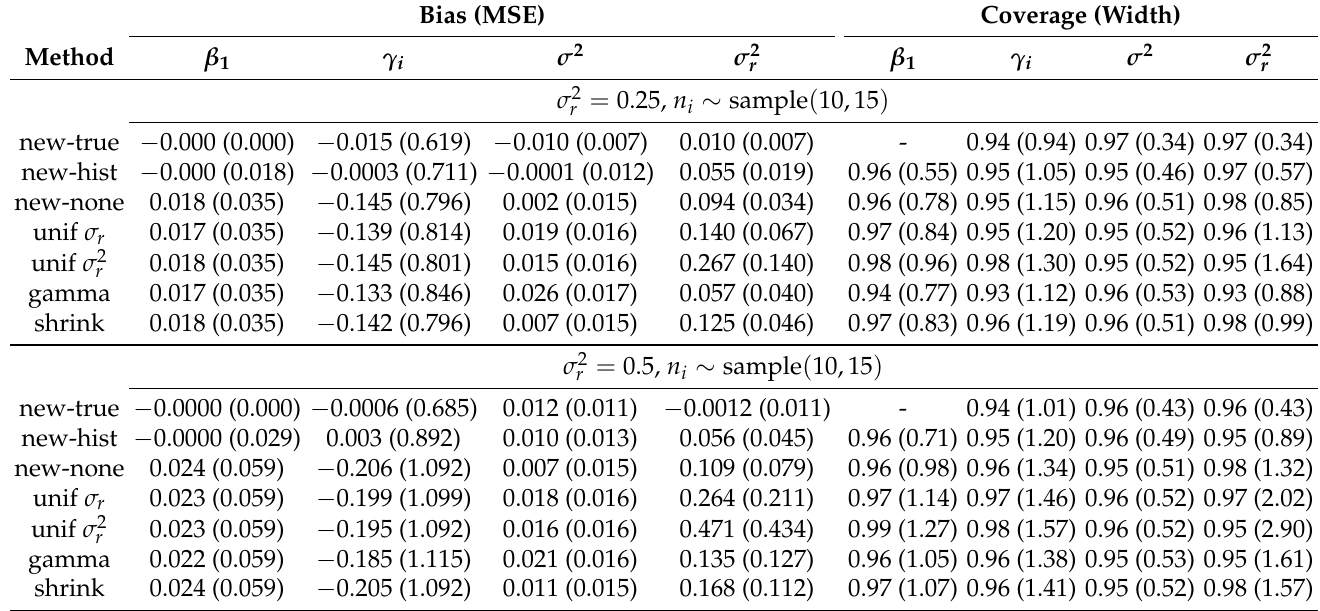
Table 3. Simulation II: Average biases (MSEs), coverage probabilities (interval widths) across 500 MC replicates in the simulation study for random one-way ANOVA